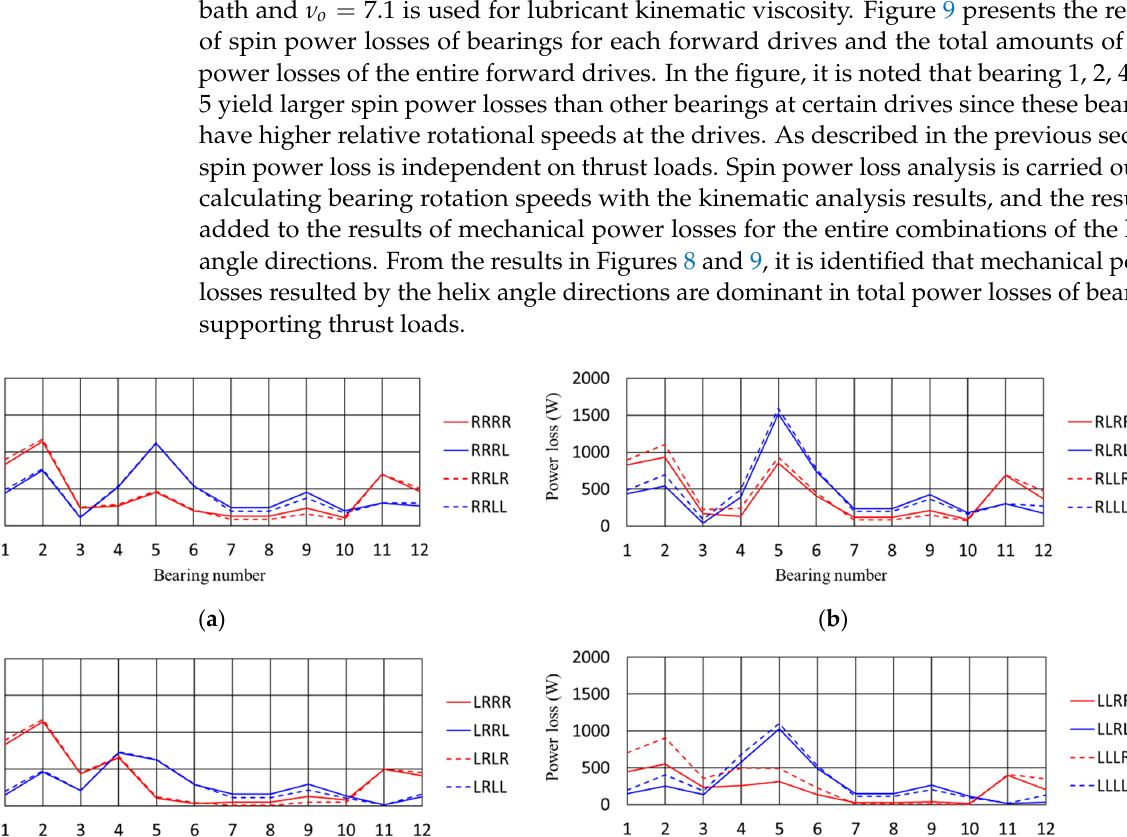
( b ) RLRR/RLRL/RLLR/RLLL directions; ( c ) LRRR/LRRL/LRLR/LRLL directions; ( d ) LLRR/LLRL/LLLR/LLLL